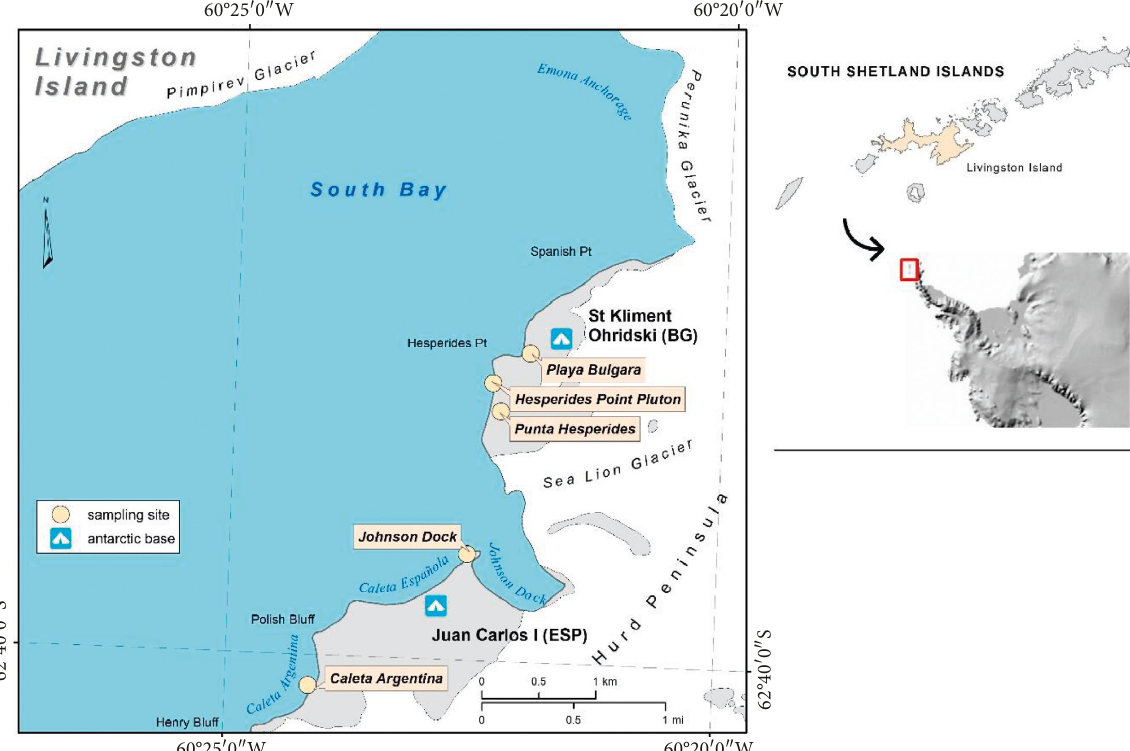
Figure 1: Study sites on Livingston Island,